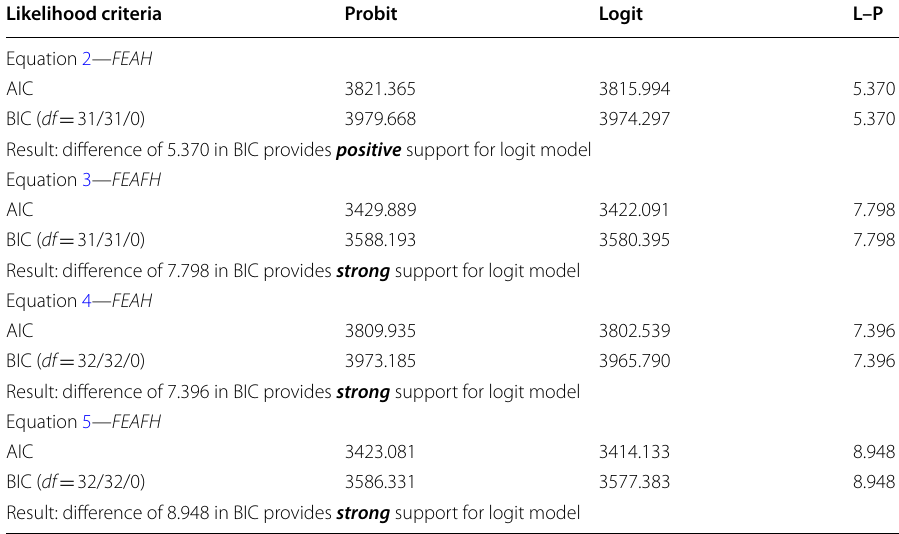
Table 10 Likelihood ratio test comparing probit versus logit models Likelihood criteria Probit